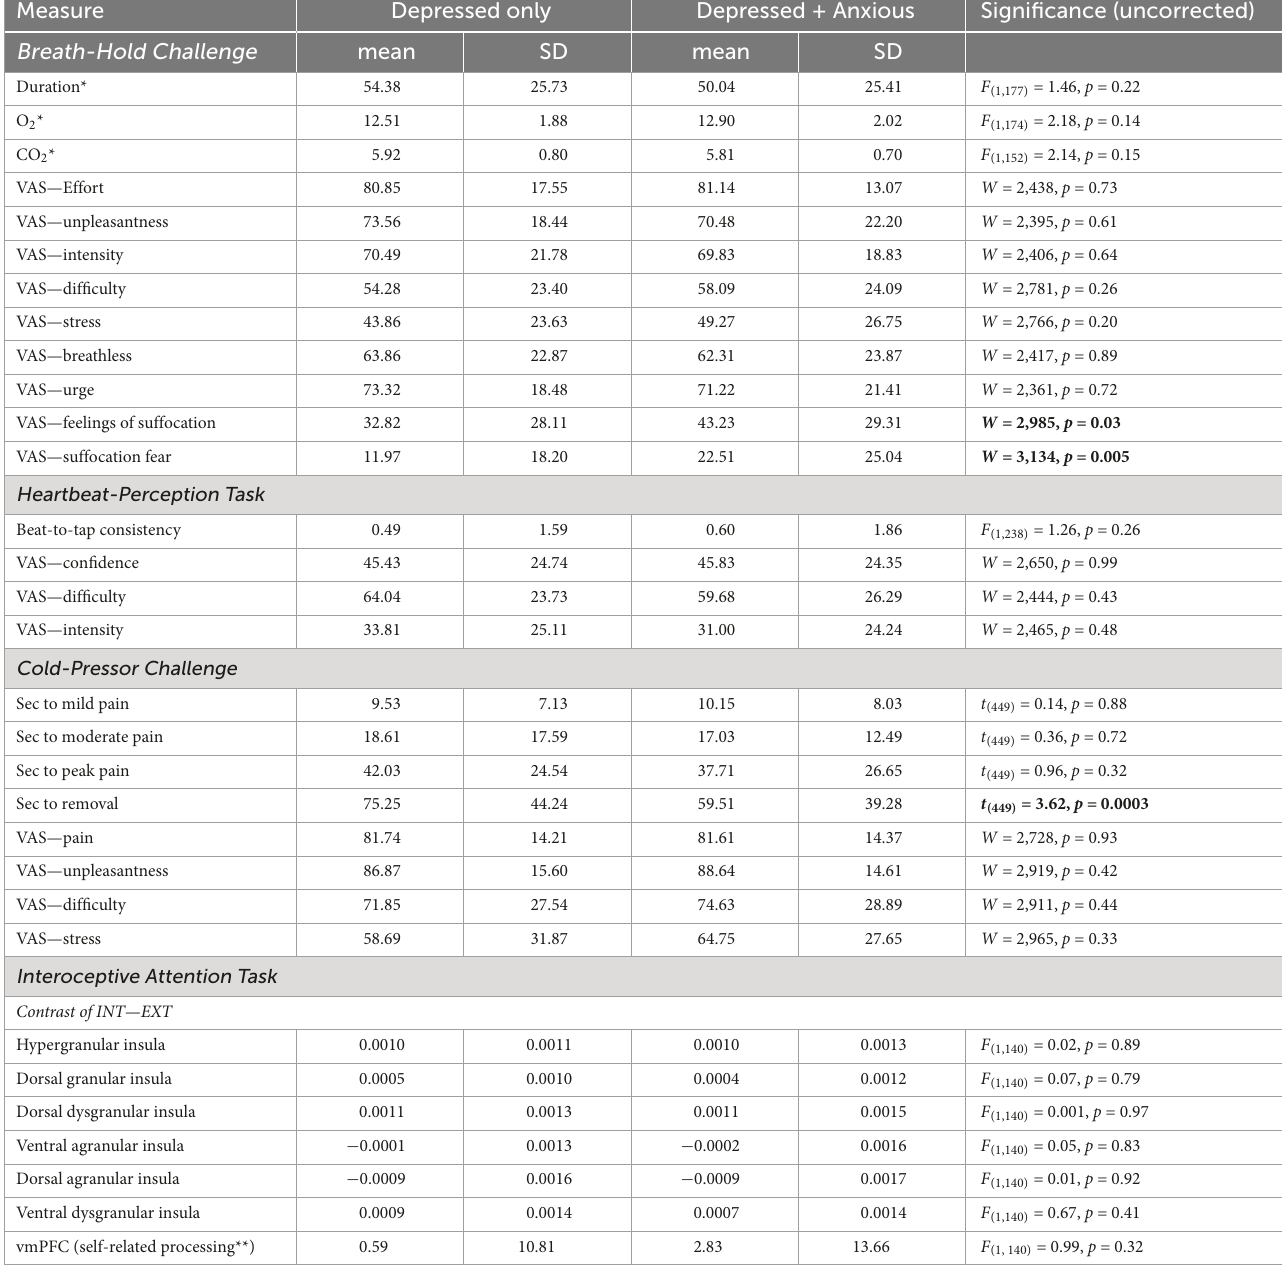
TABLE 2 Full statistical results from Breath-hold Challenge, Heartbeat-Perception Task, Cold Pressor Challenge, and Interoceptive Attention Task. Measure Depressed